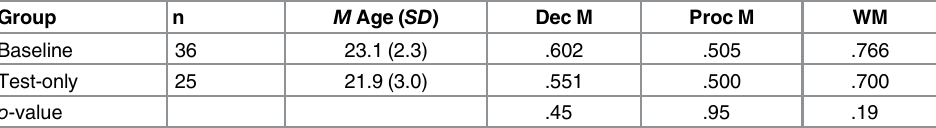
Table 1. Group sizes, mean ages, and memory measures for baseline and test-only groups in Experi- ment 1. Bottom row shows p-values from t-tests confirming that the groups were matched on each memory